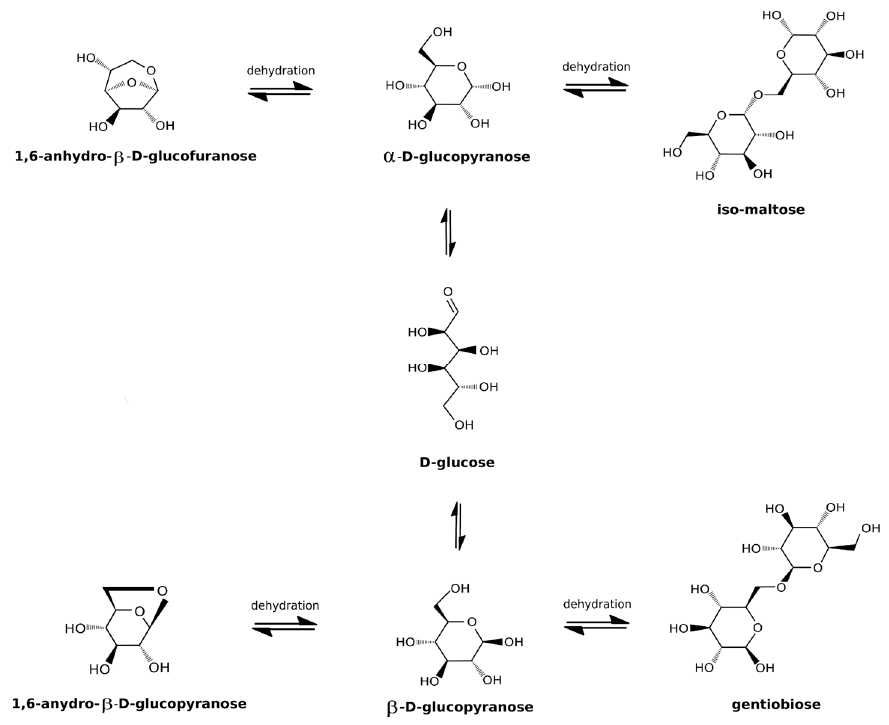
Figure 6. Reversion reactions of glucose in acid solutions [56].